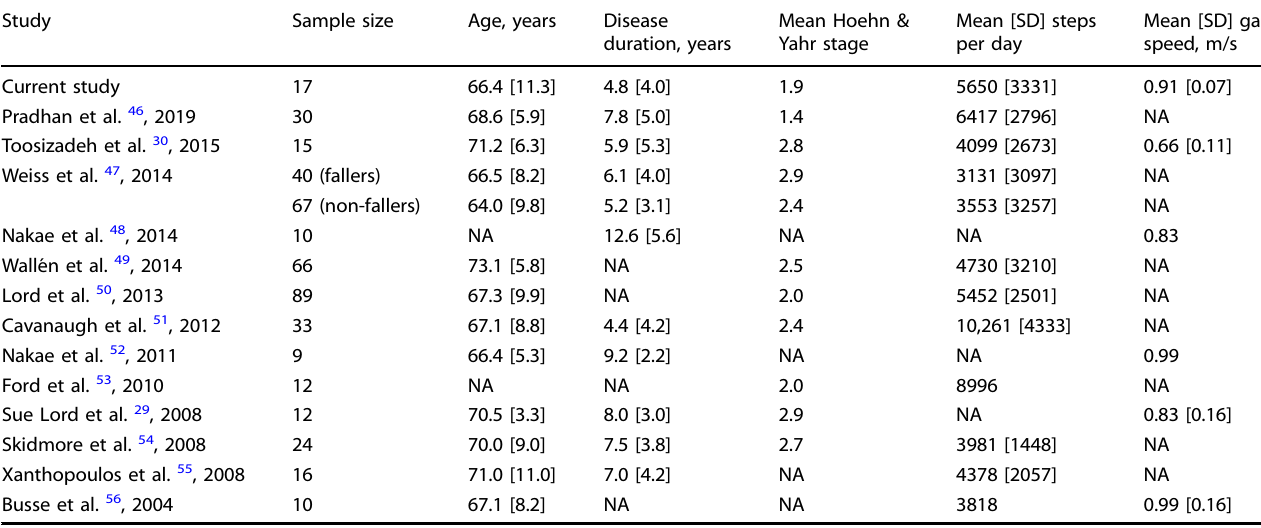
Table 3. Comparison of steps per day and gait speed for participants with Parkinson ’ s disease from recent observational studies from 2004 to 2019.